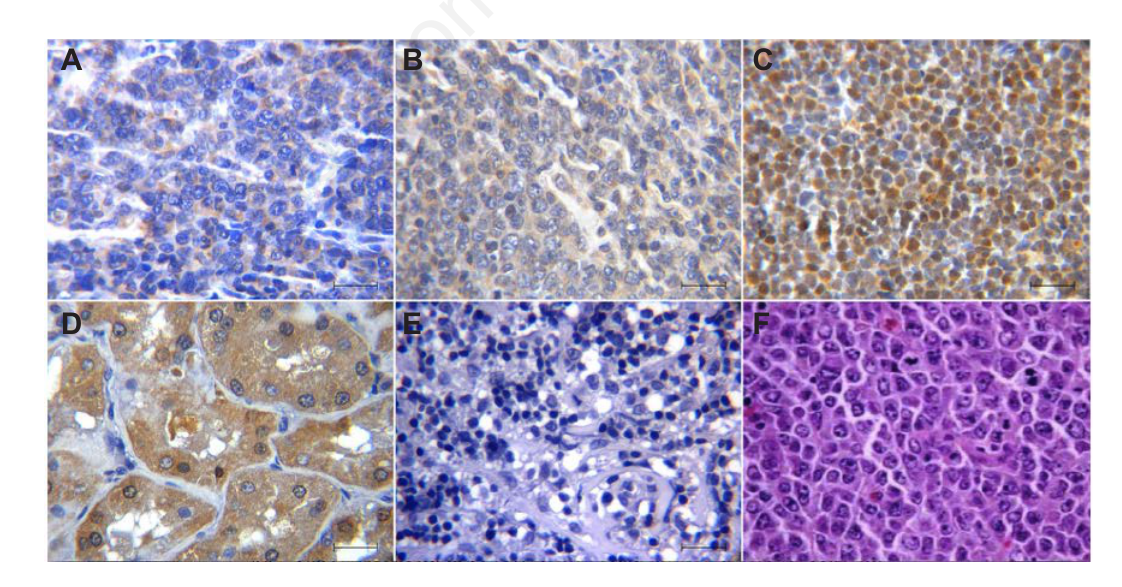
Figure 1. Osteopontin (OPN) expression immunohistochemistry in Diffuse Large B Cell Lymphoma (DLBCL). (A) Cytoplasmic OPN staining with positivity < 50%. (B) Cytoplasmic OPN staining with positivity > 50%. (C) Nuclear OPN staining. (D) Kidney sample was used as positive control of OPN. (E) Negative expression of OPN in DLBCL. (F) Hematoxylin and Eosin staining in a case of DLBCL. (A-F) Scale bar =50 m m. Immunostaining in tissues was visualized at a magnification